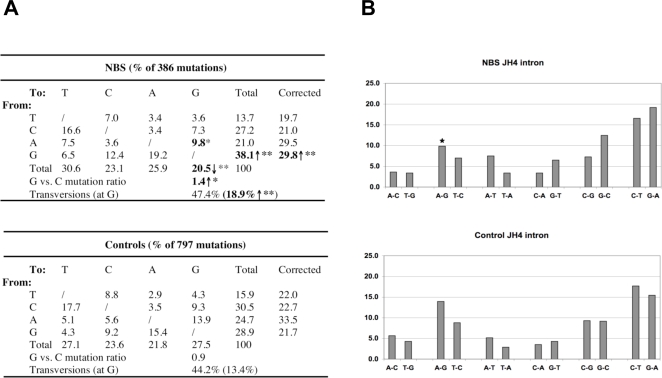
Pattern of mutations introduced in the JH4 intronic sequences.A). Nature of the base substitutions in the JH4 intronic genes. The germline sequence used for comparison contains 17.9% A, 32.1% G, 17.5% T and 32.5% C. Correction: values presented in the column were corrected to represent sequences with equal amounts of the four nucleotides. Statistical analysis was performed using χ2 test. Numbers that are significantly different from controls are bolded. *p<0.05; **p<0.01. B). Percent distribution of each type of nucleotide substitution. Stars indicate that the proportion of a given substitution is significantly different in NBS patients as compared to that in controls.